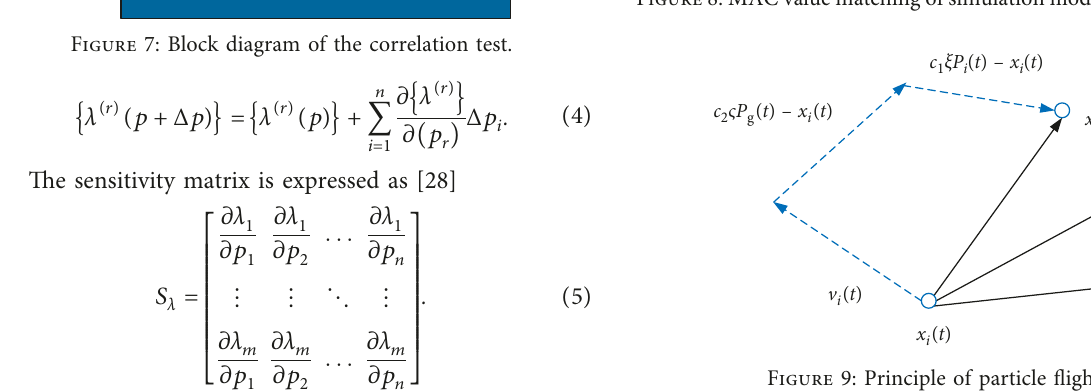
Figure 8: MAC value matching of simulation mode and test mode.